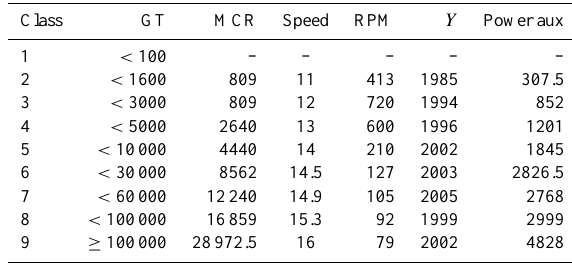
Table A3. Class medians for tankers.